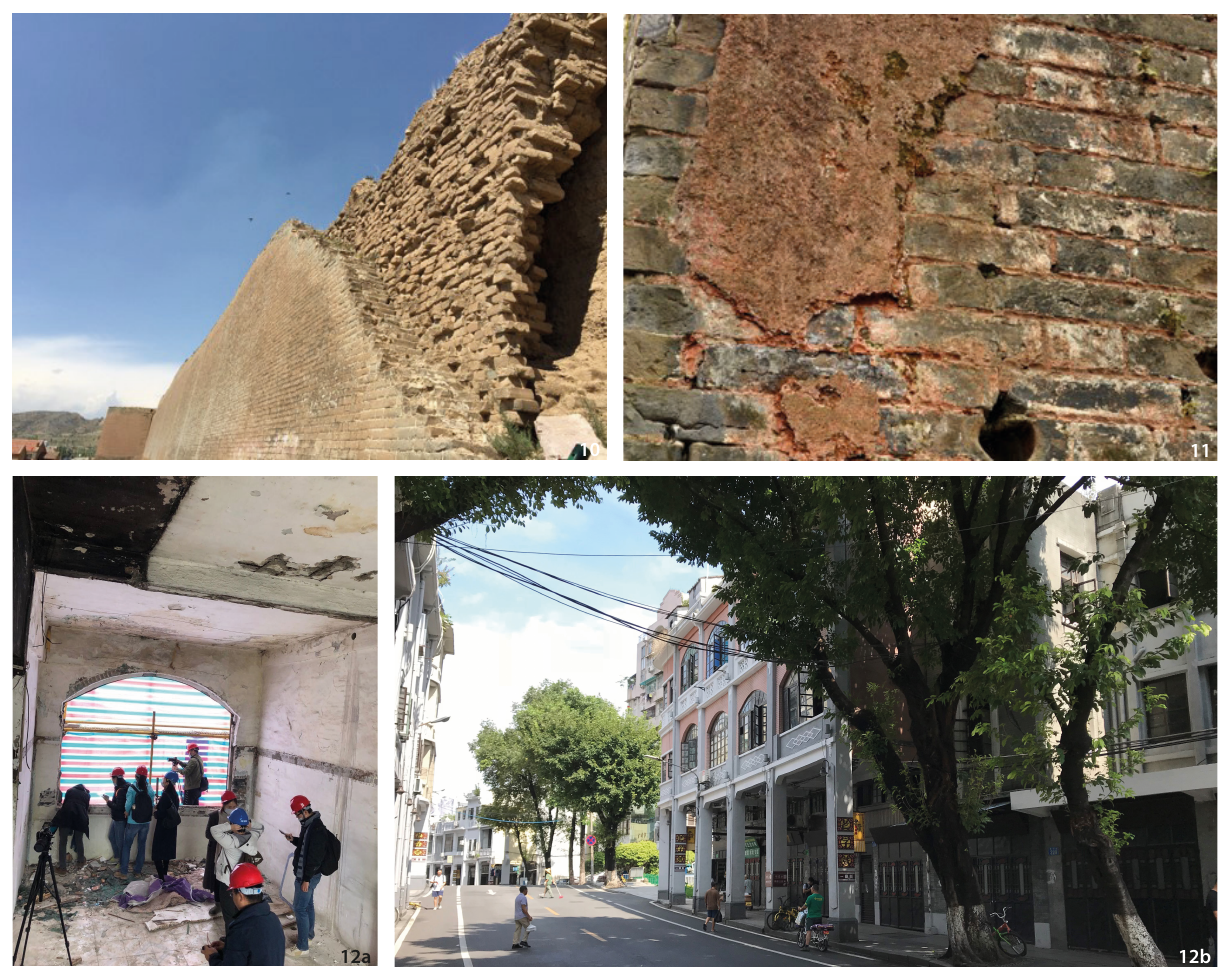
Figure 10 Ruins of the Great Wall in Zhangjiakou, Hebei Province, constructed with dolomitic lime (Source: the author). Figure 11 Historical lime plaster in China: decorative plaster from 1413, Ming Dynasty in Nanjing (Source: the author). Figure 12 Documentation of building archaeological work to reveal historic plastering technique during the redevelopment of Enning Road in Guangzhou in January 2019 (Source: the